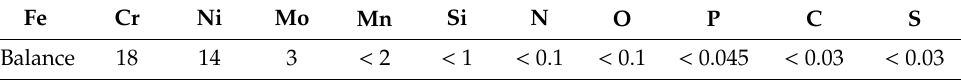
Table 1. Chemical composition of the virgin powder of 316L. All elements are in [wt %]. Fe Cr Ni